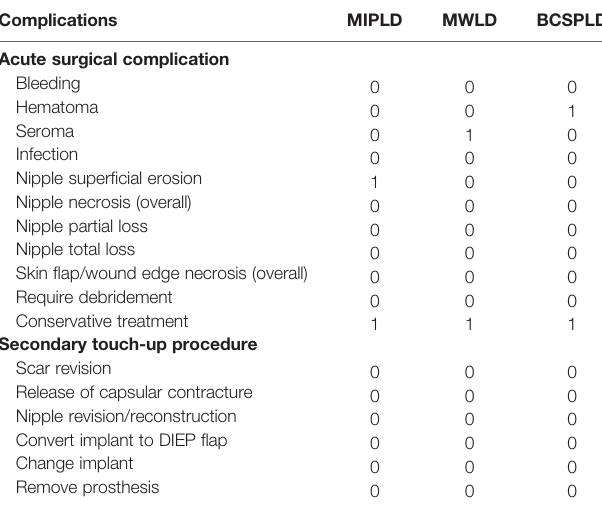
TABLE 3 | Complications of three different surgery procedures.